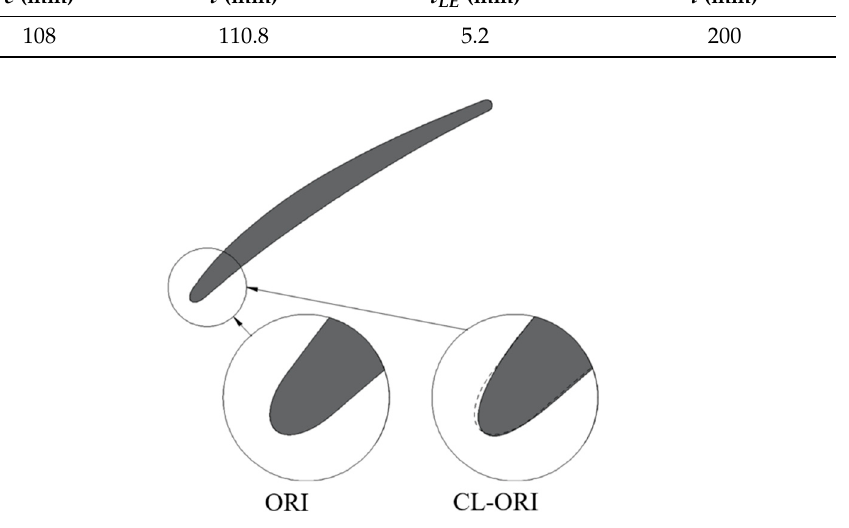
Figure 18. The blades’ leading edge shape of ORI (ellipse) and CL-ORI (continuous curvature). Table 2. The leading edge deformations and naming